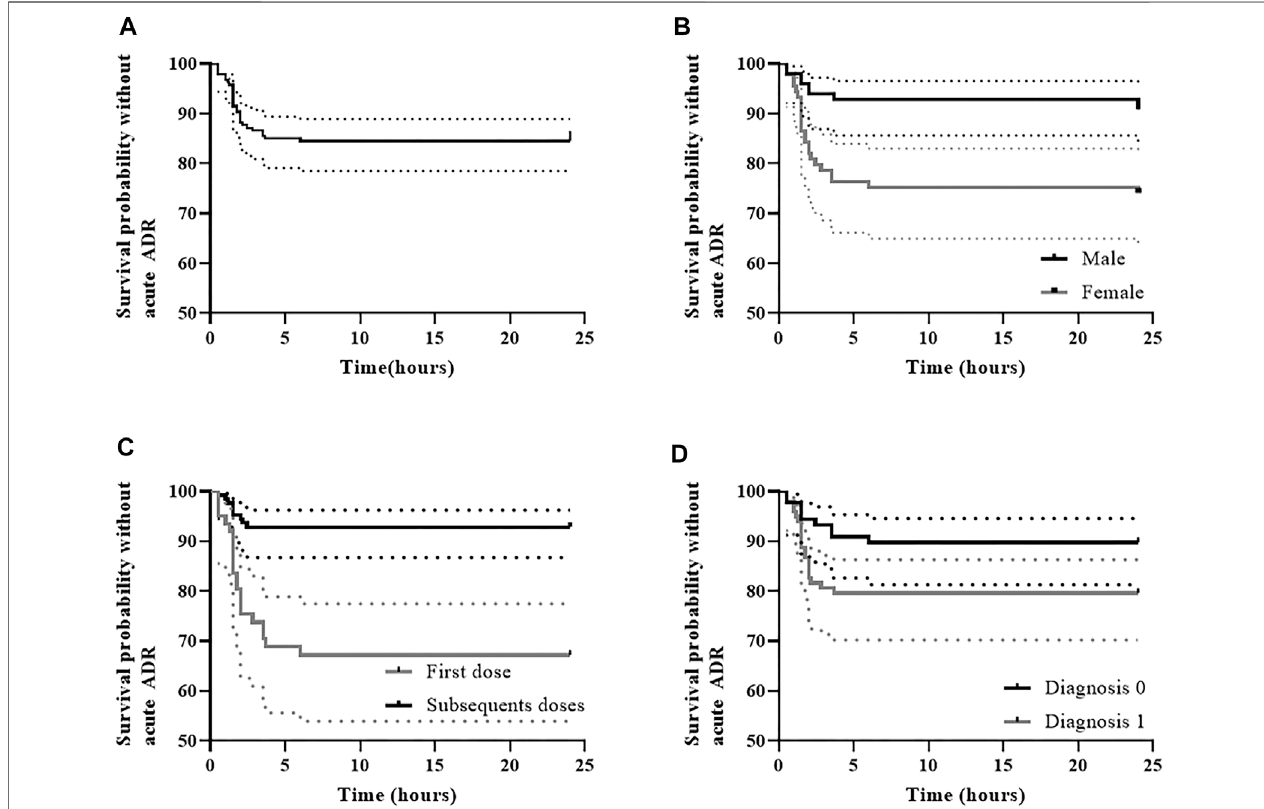
FIGURE2| Rituximabinfusion-related reaction-free survival (A) and IRR-free survivalaccordingtothevariables retained inmultivariableanalysis,including (B) sex, (C) fi rst dose versus subsequent doses, and (D) type of diagnosis. (A) IRR-free survival was 84.5% (95% CI, 79.5 – 89.8) at 6 h post-initiation of rituximab therapy; ( B) In males IRR-free survival was 92.9% (95% CI, 87.9 – 98.1) at 6 h post-initiation of rituximab therapy, whereas in females it was 75.3% (95%CI, 66.8 – 84.8); (C) IRR-free survivalwas 67.2% (95% CI,56.4 – 80.1) during the fi rst dose at 6 h post-initiation ofrituximab therapy, whereas in subsequent doses survivalwas92.9% (95% CI, 88.5 – 97.5); ( D) In patients with diagnosis 0 (O-HSCT-SOT), IRR-free survival was 89.9% (95% CI, 83.8 – 96.4) at 6 h post-initiation of rituximab therapy, whereas it was 79.6% (95% CI, 72.0 – 88.0) in patients with diagnosis 1 (N-IHR).